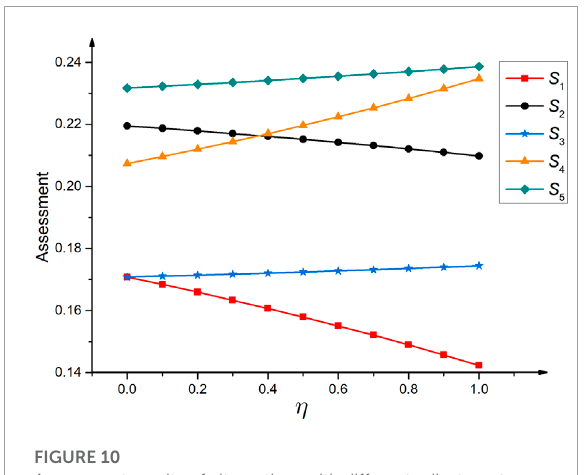
FIGURE 10 Assessment results of alternatives with different adjustment factor η